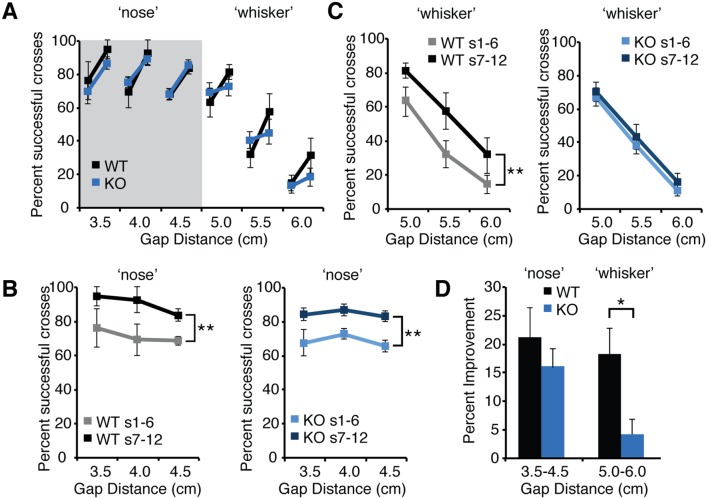

Fmr1 KO mice display normal learning on the gap cross assay at shorter gap distances but impaired learning at longer whisker-dependent distances.(A) The percent successful crosses averaged across the first six sessions and subsequent six sessions across gap distances ranging from 3.0 cm to 6.0 cm for both wild-type mice (black lines, n = 6) and Fmr1 KO mice (blue lines, n = 9). For each distance, the line marker on the left is the average success rate of the first six sessions and the connected line marker on the right is the average success rate of the subsequent six sessions. Error bars represent standard error of the mean. (B) At shorter ‘nose’ distances, both wild-type (WT) and Fmr1 KO mice (KO) improve to a greater percentage of successful crosses between the average of the first six sessions (WT, grey, KO light blue) and the last six sessions (WT, black, KO dark blue). This improvement is statistically significant (WT, p = .007; n = 6; KO, p<.001, n = 9; WT; two-way ANOVA) (C) At whisker-dependent distances, wild-type (WT) improve between early sessions (grey line) and subsequent sessions (black line) despite the lower overall success rate at increasing gap distances. However, KO mice do not display significant improvement between early sessions (light blue line) and later sessions (dark blue line) (WT, p = .002, n = 6, KO, p = .14; n = 9, two-way ANOVA). (D) Average improvement for WT and KO mice at shorter ‘nose’ distances and longer ‘whisker’ distances. WT mice display significantly greater improvement at whisker-dependent distances that KO mice (p = .02, two-tailed t-test).